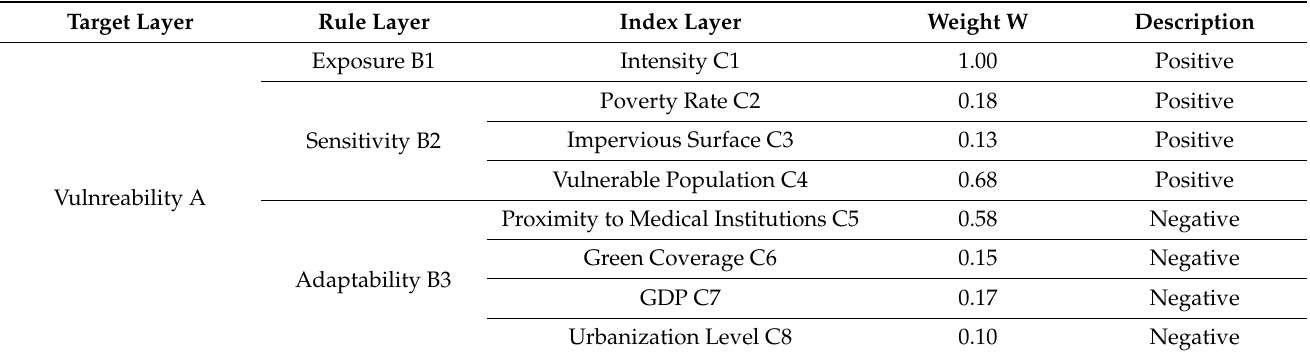
Table 2. Hierarchy of heat health vulnerability assessment and the weight of each indicator. The field, named Description, shows the impact of each index on HHV as positive (aggravate the vul- nerability of heat-related morbidity/mortality) or negative (reduce the vulnerability of heat-related